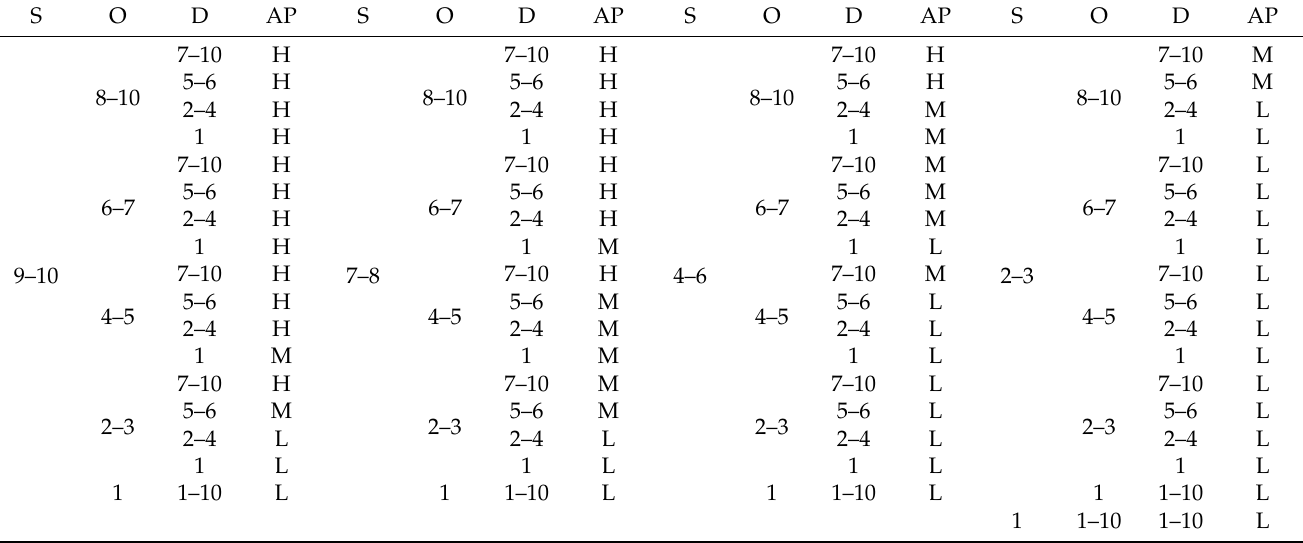
The conversion table of S, O, D numbers in the new-edition design (D)/process (P) in FMEA and H, M, L in AP is shown in Table 1. Table 1. D/P FMEA S, O, and D of